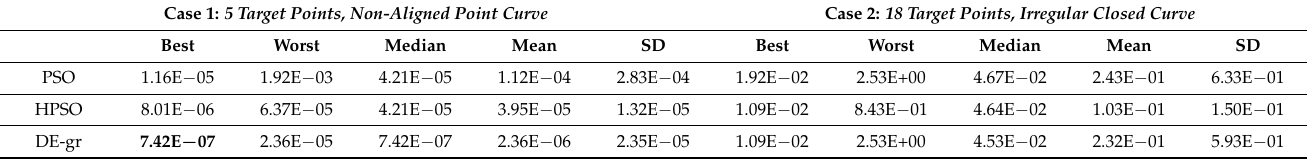
Table 2. Results of optimized values and statistical analyses of five representative